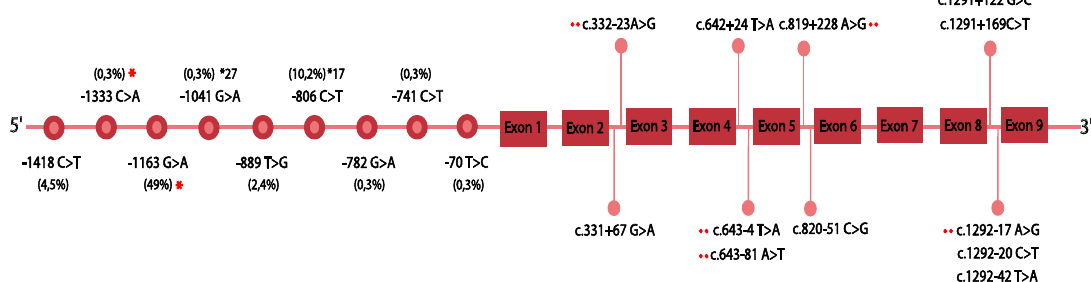
Figure 2. Promoter and intronic variants. CYP2C19 genetic variants in promoter and intronic regions are described. Numbers in parentheses represent allele frequencies; * indicates novel variants and ¨ illustrates a predicted potential splicing